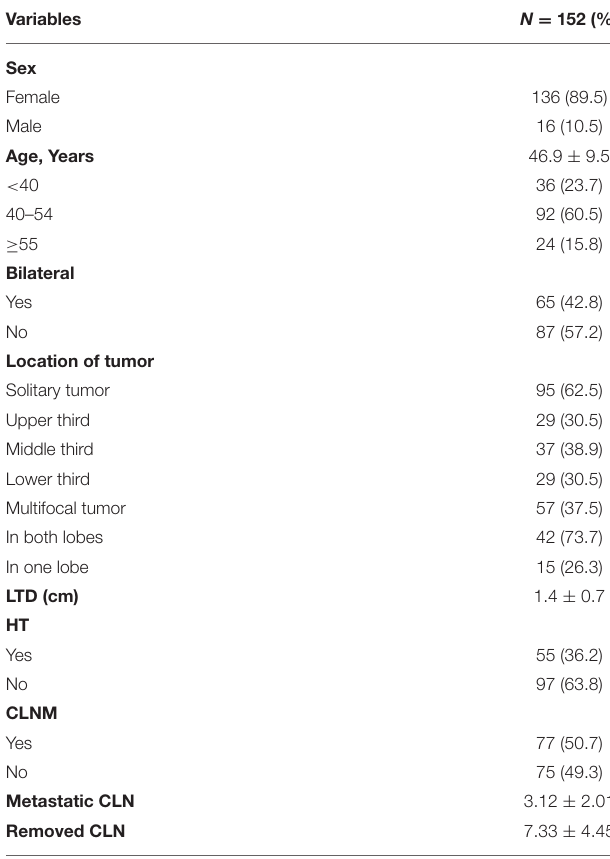
TABLE 1 | Clinicopathological characteristics of cN0 PTC with